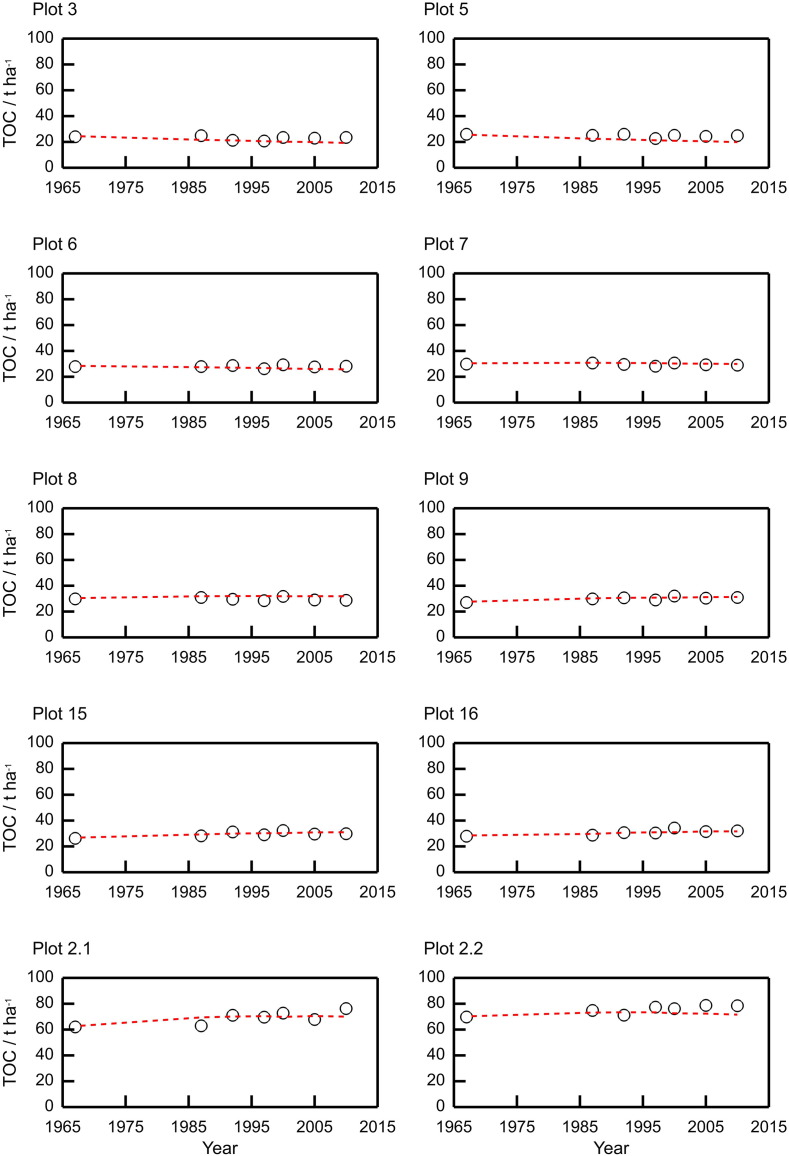
Measured (black circles) and modelled (red dashed lines) soil total organic carbon (TOC) for ten plots from the Broadbalk long-term wheat experiment. The measured values were averaged over Sections 1 and 9.